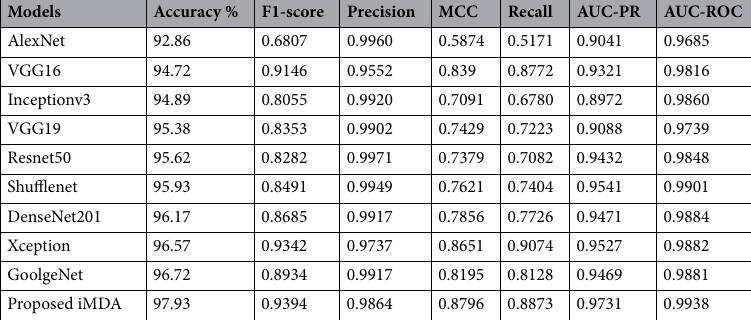
Table 2. Comparison of proposed framework with the existing CNN models.